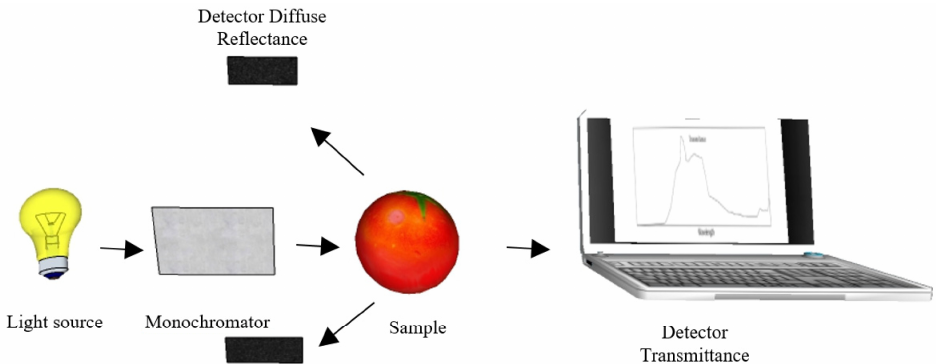
Figure 7. Elements that integrate an optical system of spectroscopy (NIR) [72].